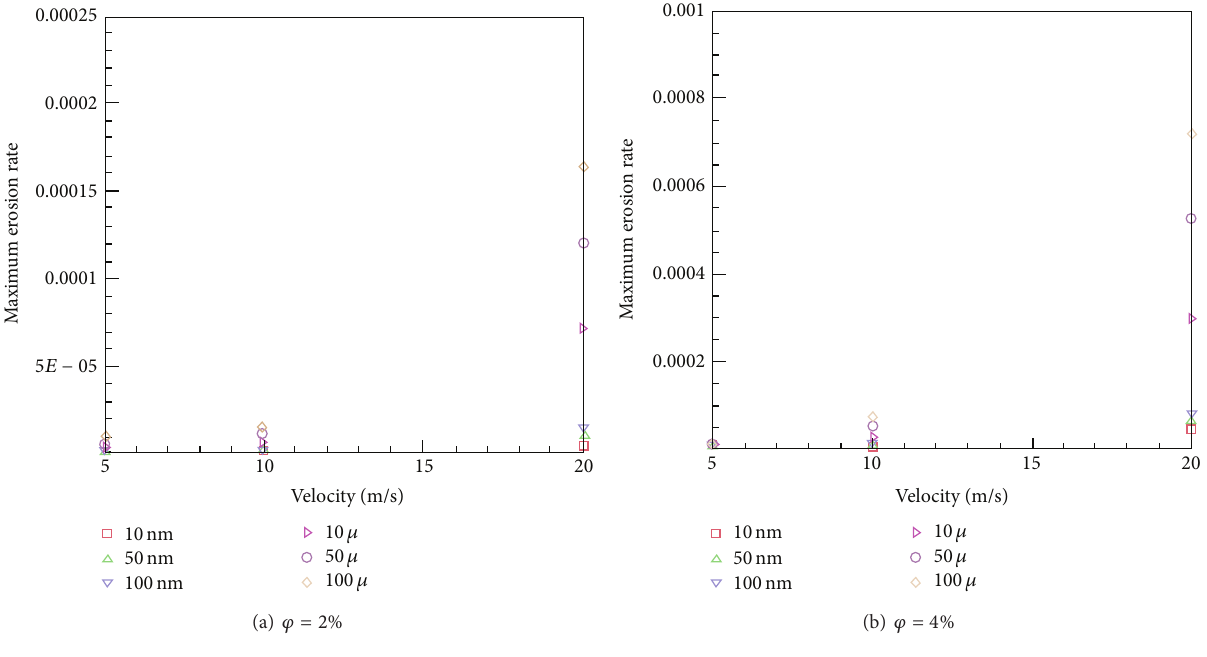
Figure 5: The variation of maximum erosion rate with velocity.